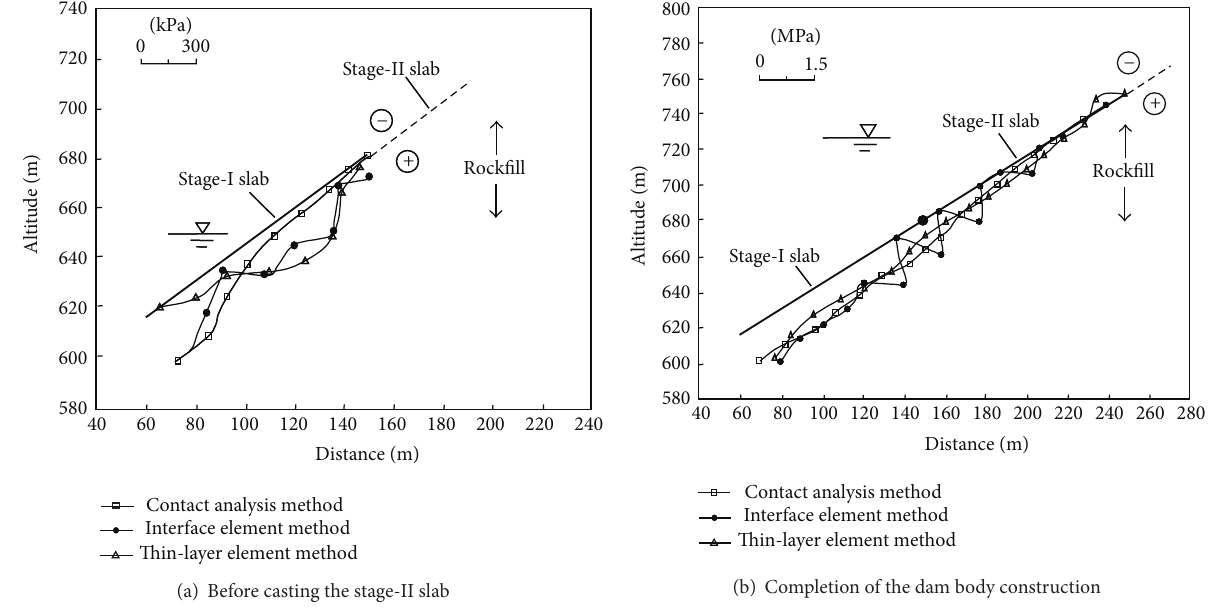
Figure 13: Comparison of normal contact stress along the